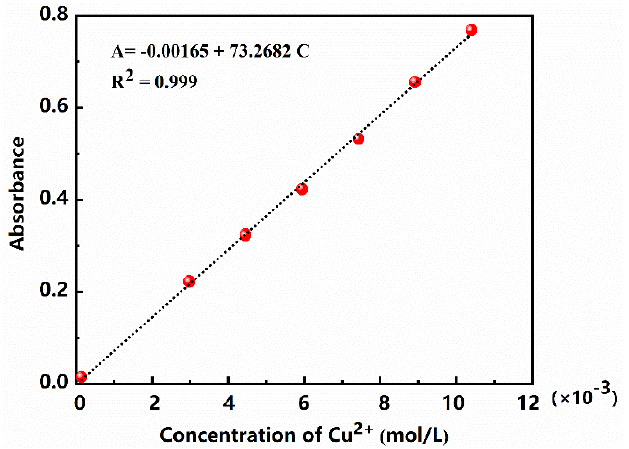
Figure 8. Working curve of Cu 2+ .